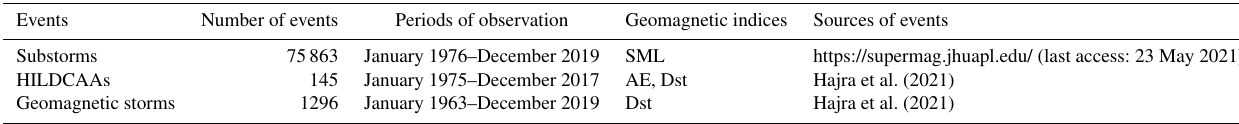
Table 1. Details of the geomagnetic activity events under present study.